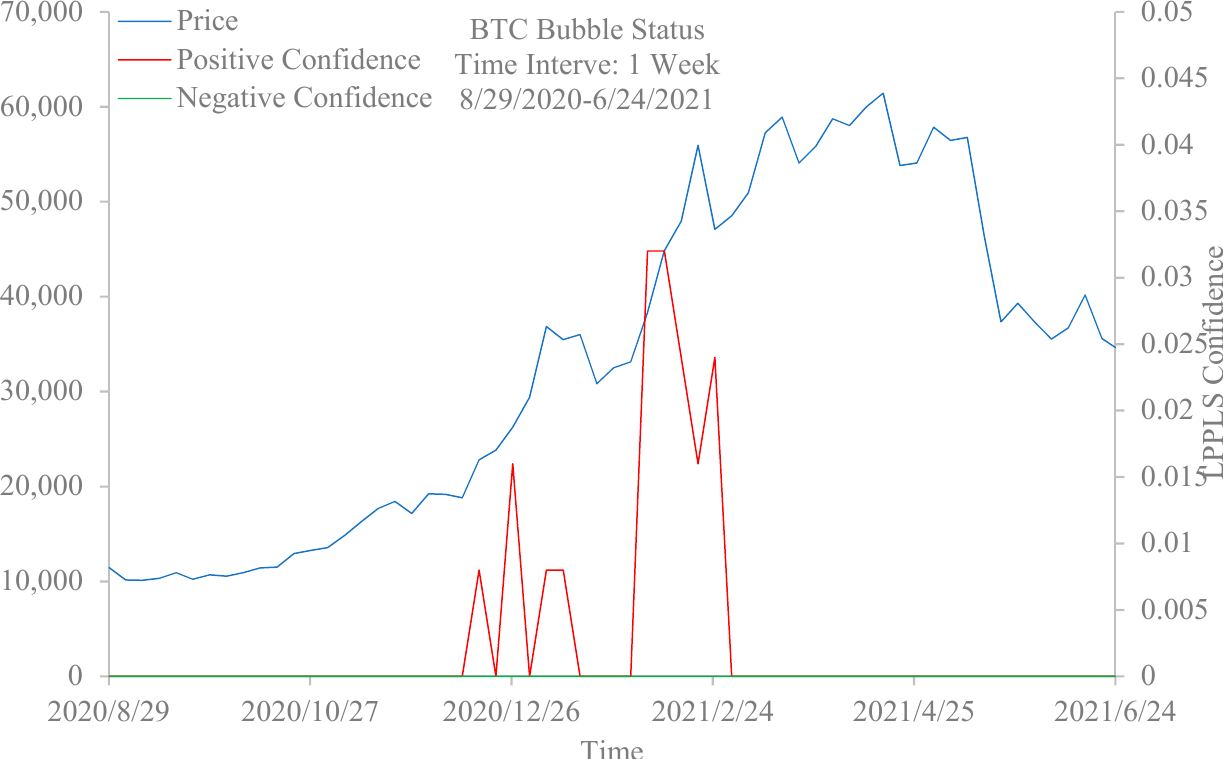
Figure 7. Weekly LPPLS confidence indicator for positive bubbles is shown in red and negative bubbles in green (right scale), along with the Bitcoin price in blue (left scale) from 8/29/2020 to 6/24/2021.